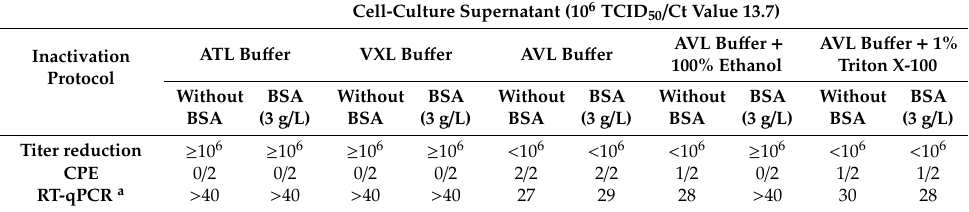
Table 2. SARS CoV-2 cell-culture supernatant inactivation using lysis bu ff